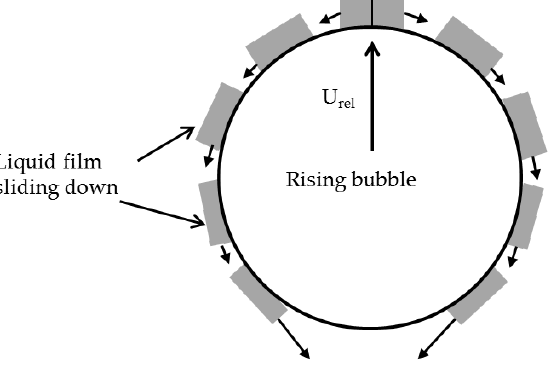
Figure 2. Schematic representation of the penetration